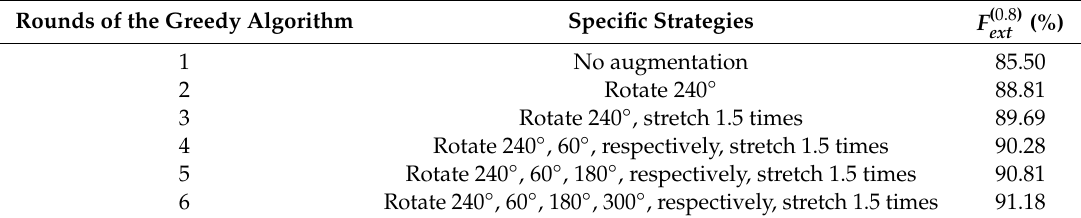
Table 5. Search results of the greedy algorithm in the inference process. Rounds of the Greedy